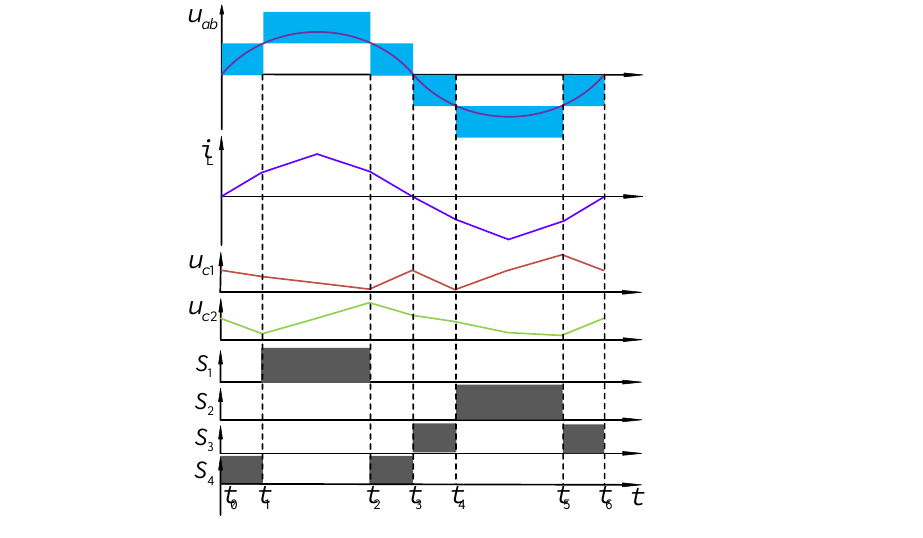
Figure 5. Key operating waveforms of the STL-PFC in theory. Mode 2 [ t ∈ ( t 0 , t 3 )]: Only the switch S 1 is turned ON, as shown in Figure 4b. In this mode, the capacitor C 2 is charged, the capacitor C 1 provides energy to the load R L , and the voltage u ab = + u c 2 = +0.5 u dc . During this state, if the power supply voltage is higher than 0.5 u dc , the inductor current i L increases linearly. Correspondingly, if the power supply voltage is lower than 0.5 u dc , the inductor current i L decreases linearly. The equation of this mode can be obtained as follows: